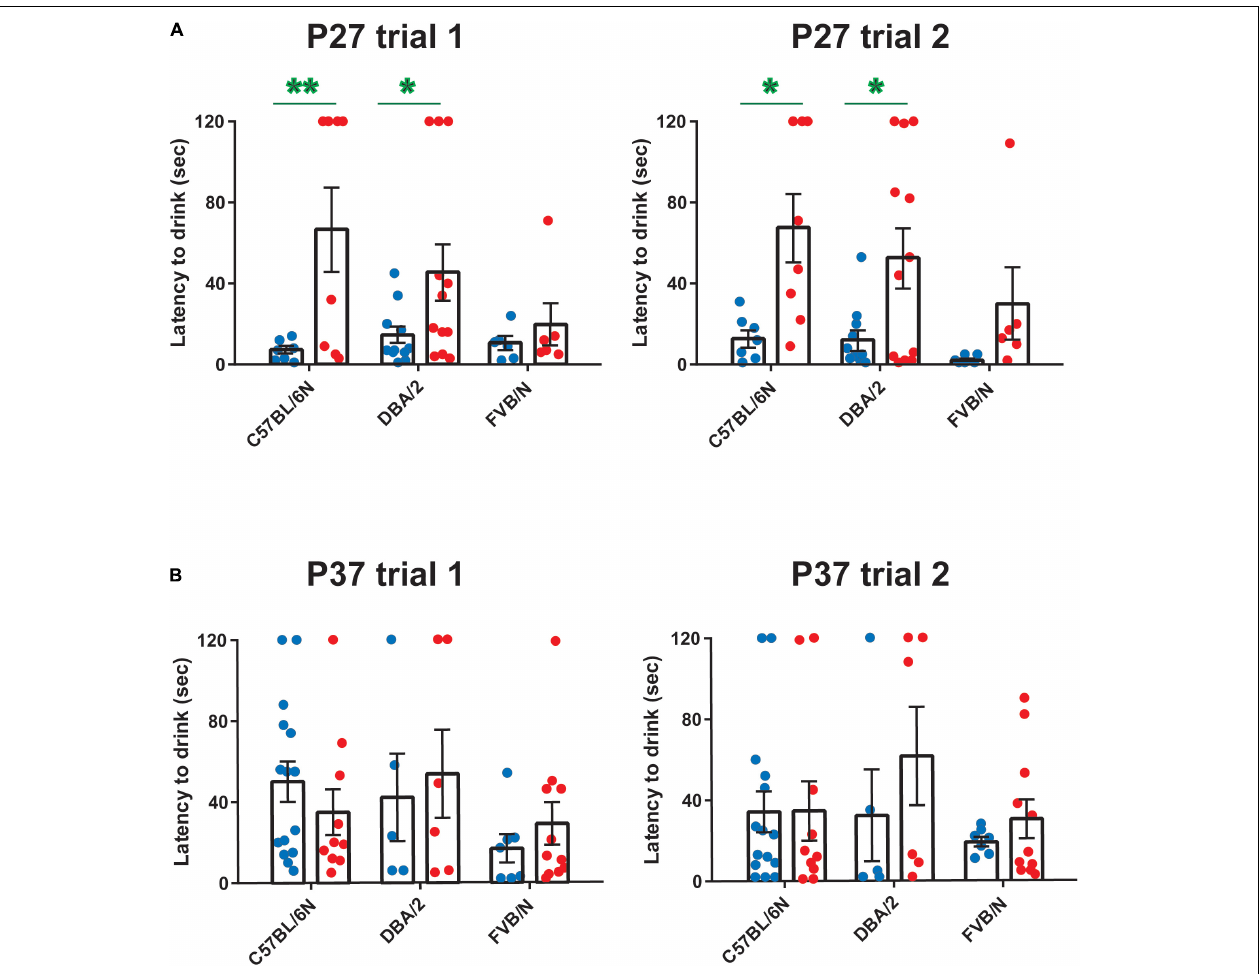
FIGURE 4 | Anxiety-related hyponeophagia test at P27 and P37. Female C57BL/6N and DBA/2 mice showed an increased latency to drink the diluted milk compared to male mice in both trials 1 and 2 at P27 (A) but not at P37 (B) . At both P27 and P37, no strain difference was found in the latency to drink the diluted milk. The green asterisk indicates a significant difference between males and females. Two-way ANOVA followed by Tukey post hoc test,* p ≤ 0.05, ** p ≤ 0.01. Blue and red dots represent males and females, respectively. Error bars indicate the standard error of the mean